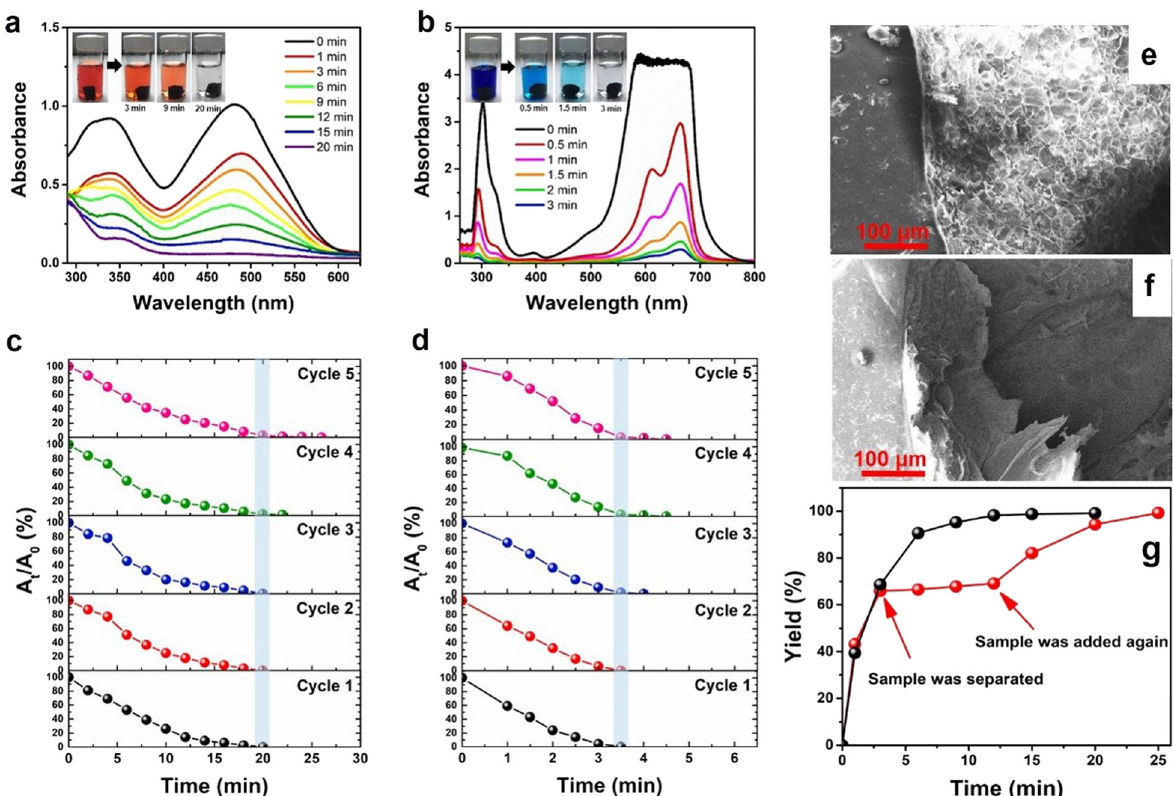
Fig. 5 The dye degradation and the reusability of the DPAS@P-GOM hydrogel. The reduction of a CR and b MB degraded by DPAS@P-GOM hydrogel. Reduction of c CR and d MB for fi ve successive cycles with the same batch of DPAS@P-GOM hydrogel. SEM images of the freeze-dried e DPAS@P-GOM and f DPAS hydrogel in CR solution for fi ve cycles. g Catalytic activity of the DPAS@P-GOM hydrogel in the redox reaction of CR and NaBH 4